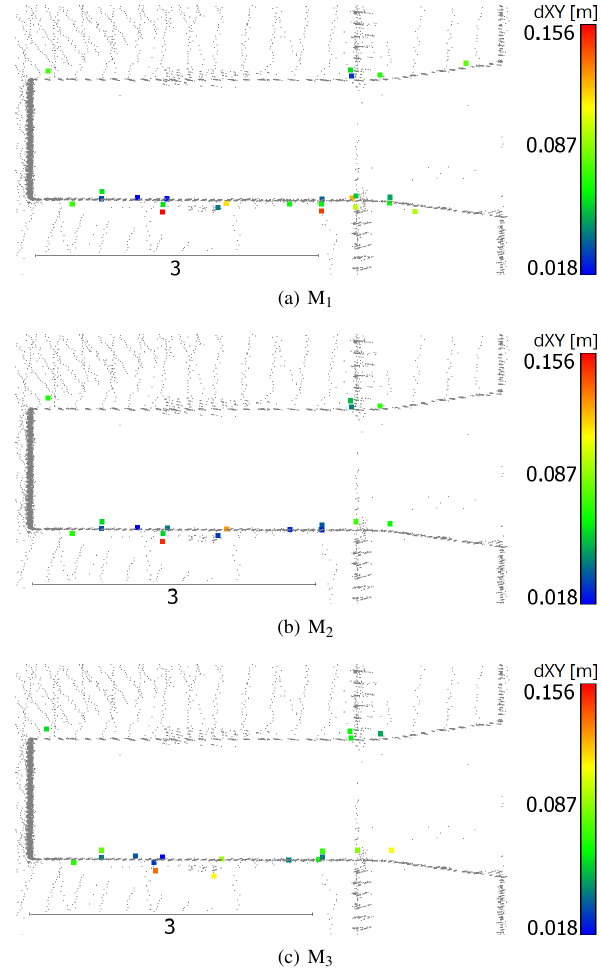
Figure 9. Deviation dXY between refraction corrected ALS point clouds (colored) and TLS point cloud (grey) at the concrete base in meter.